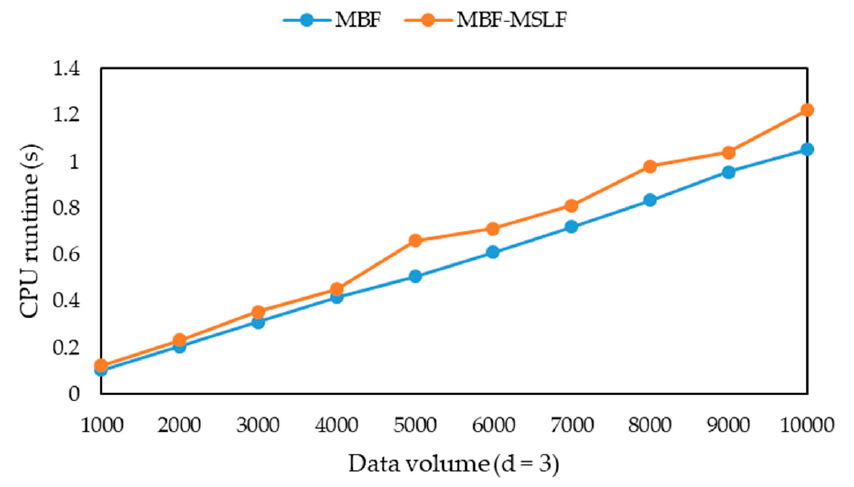
Information 2019 , 10 , x FOR PEER REVIEW Figure 3. The suppression ratio of MBF and MBF-MSLF with different data volumes ( d = 3). Figure 3. The suppression ratio of MBF and MBF-MSLF with di ff erent data volumes ( d = 3).